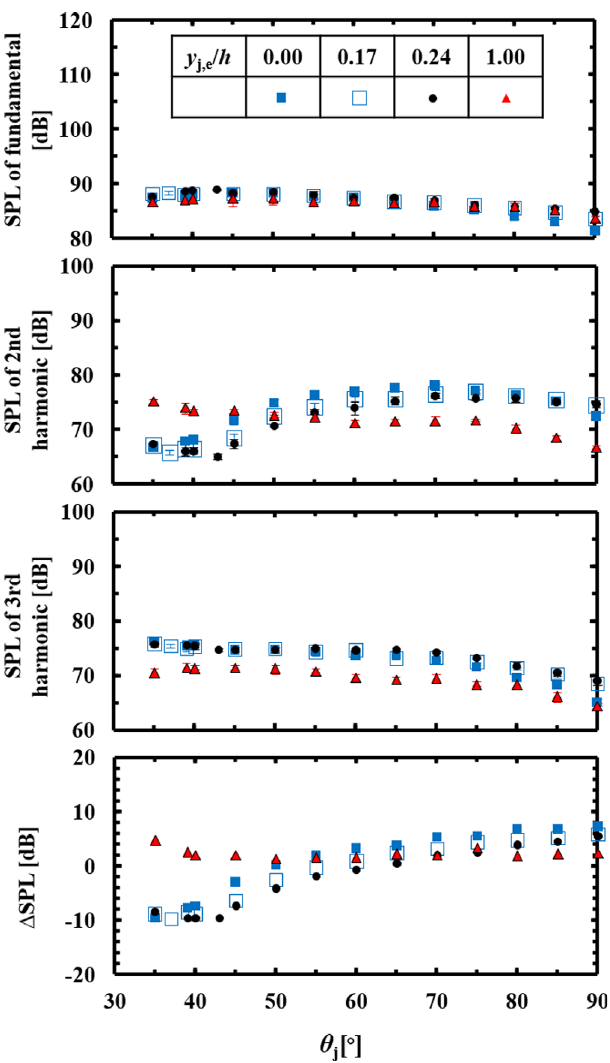
Figure A.1. Variations of harmonic structure with jet angle measured for fl ute with A4 fi ngering. Lip-to-edge distance was fi xed to the actual blowing condition shown in Table 1 ( l / h = 5.6).